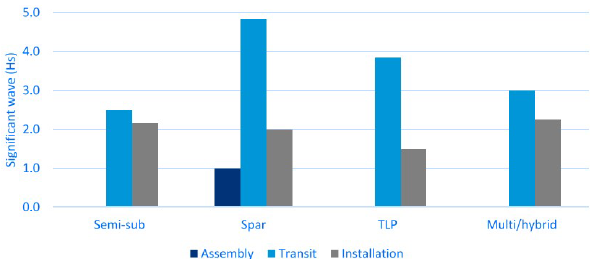
Figure 7. Significant wave height limitation during assembly, tran- sit and installation (James and Ros,